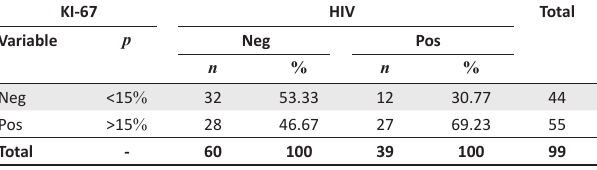
TABLE 4: KI-67 protein receptor status by human immunodeficiency virus status ( p = 0.0383). KI-67 HIV